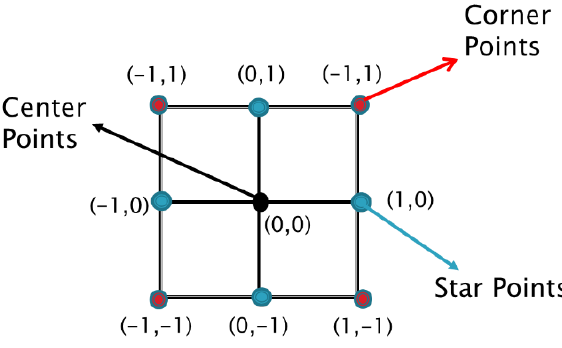
Figure 6. Face-centered CCD for ECM parameter surface.